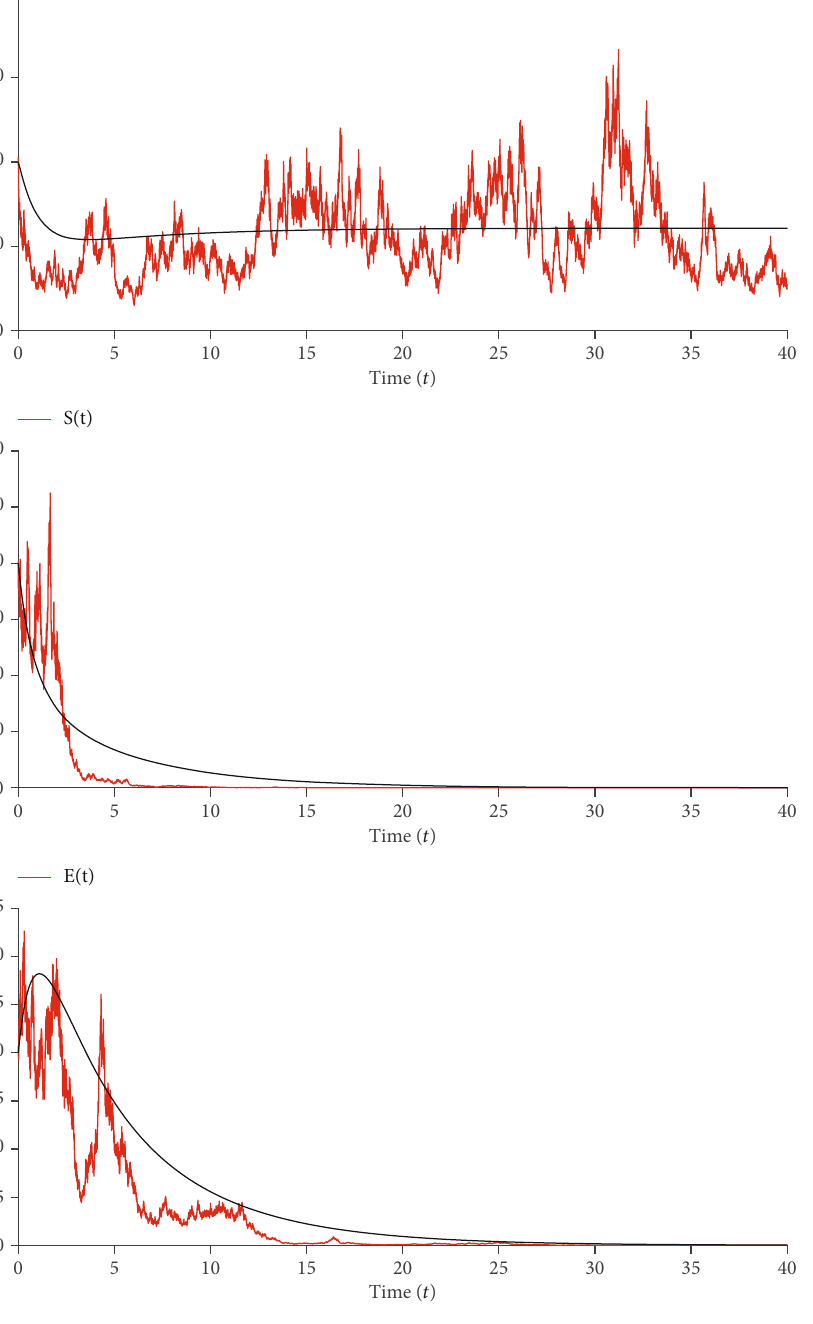
ð α Þ = 0 : 01 , π ð α Þ = 0 : 1 , π ð α Þ = 0 : 04 , π = 0 : 6 , σ = 0 : 7 , σ = 0 : 6 , σ = 0 : 6 , σ = 0 : 6 , π 1 2 3 4 5 1 2 3 4